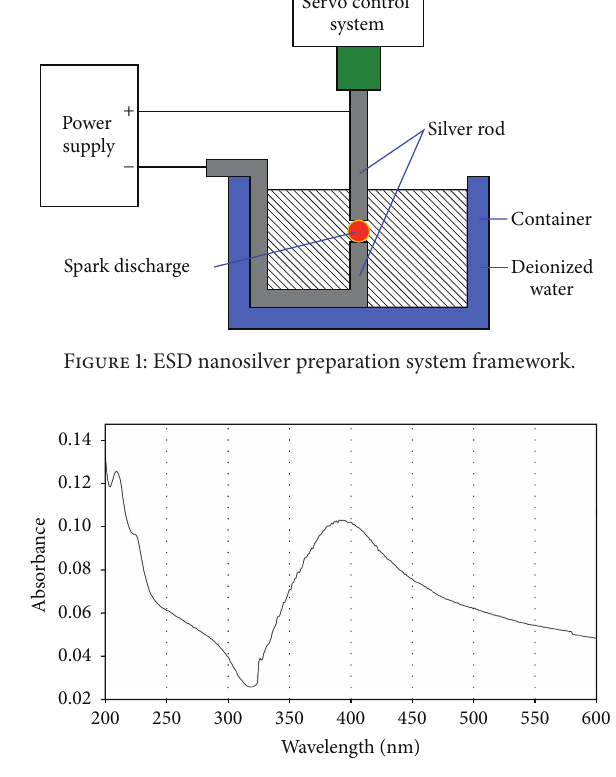
Figure 2: UV absorption spectrogram of water phase nanosilver.